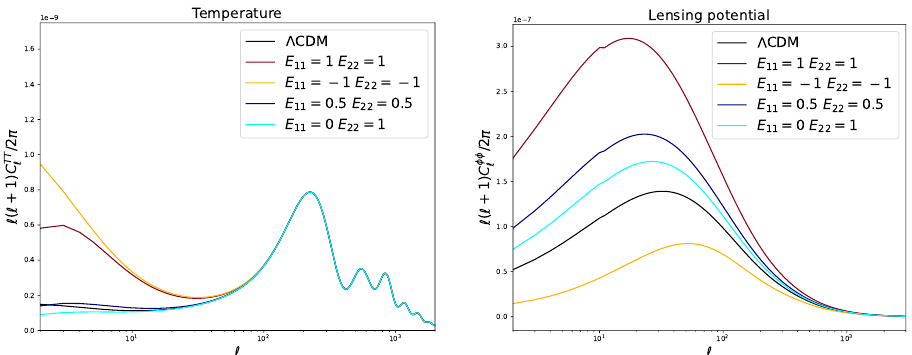
Figure 1. Temperature ( left ) and lensing potential ( right ) CMB power spectra obtained for possible departures from GR. This figure is obtained using the same parameterization and parameter values in [75] using a private